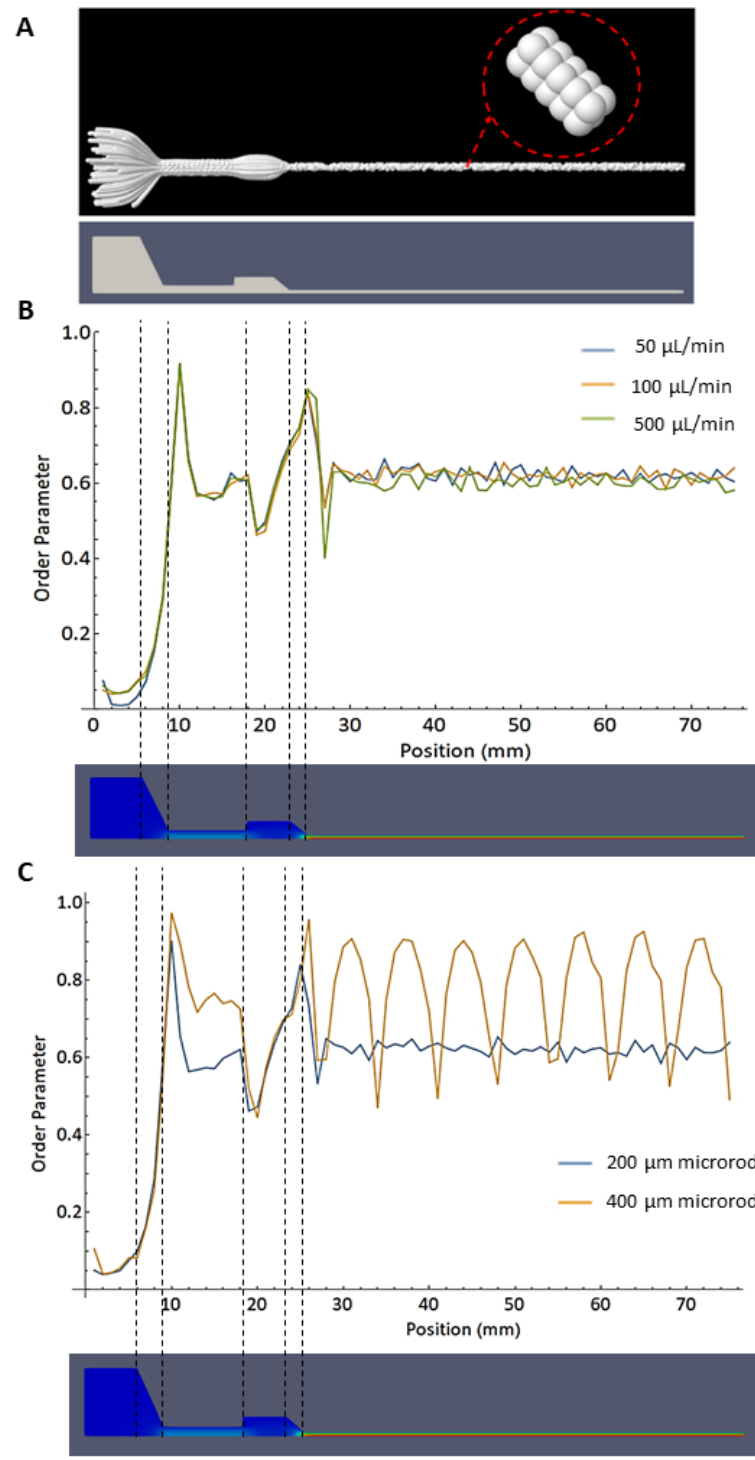
Figure 10. ( A ) Simulation with 100 microrods of 200 µm length. Multiple time steps are overlapped to observe the trajectory they follow. Variations of the orientational order parameter S (see Eq uation (10)) along the geometry, calculated for ( B ) 50, 100, and 500 µ L/min flow rate (constant parameters: 200 µm microrods, needle diameter 0.8 mm) and ( C ) microrod’s lengths of 200 and 400 µm (constant parameter: 100 µ L/min flow rate). For comparison, the contour of the syringe and needle is shown below.